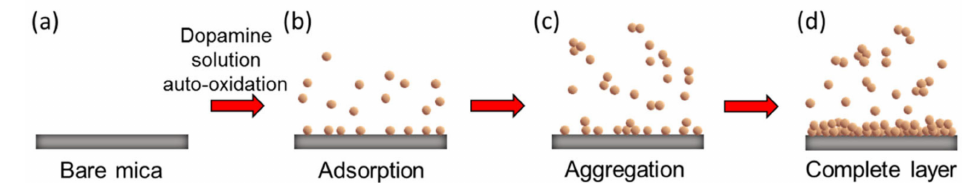
Figure 3. Schematic of mechanism of deposition of PDA on mica surface ( a ) bare mica, ( b ) adsorption of dopamine on mica surface, ( c ) aggregation of dopamine, and ( d ) layer formation on mica surface.